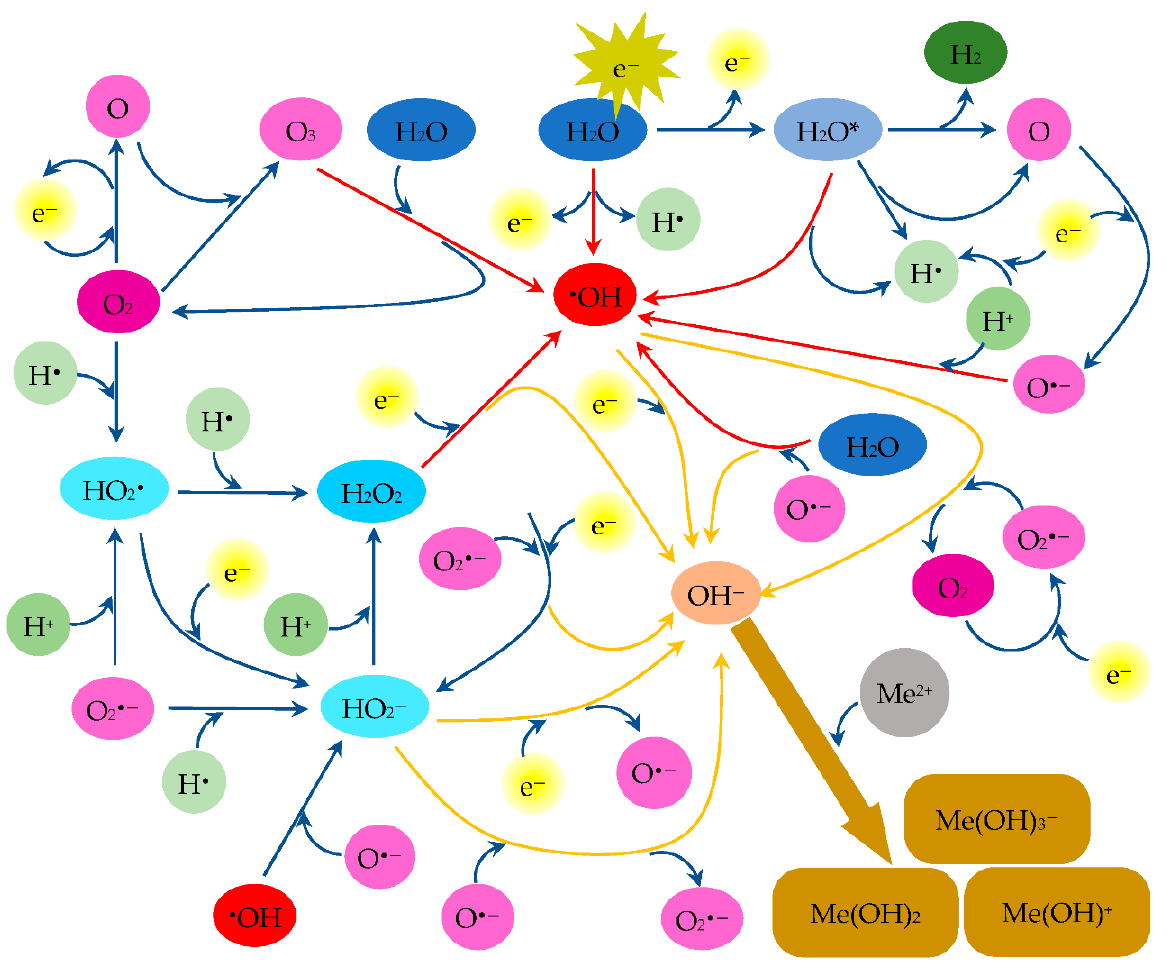
Figure 13. Suggested mechanism of metal ion precipitation in the aqueous solution due to nonthermal plasma (selected reactions).